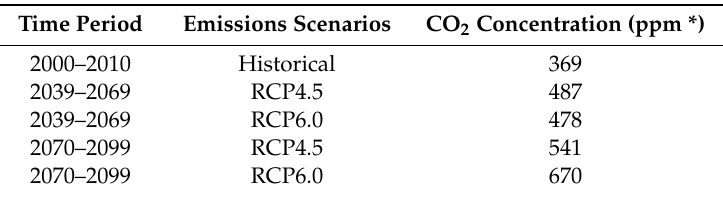
Table 4. CO 2 concentration for